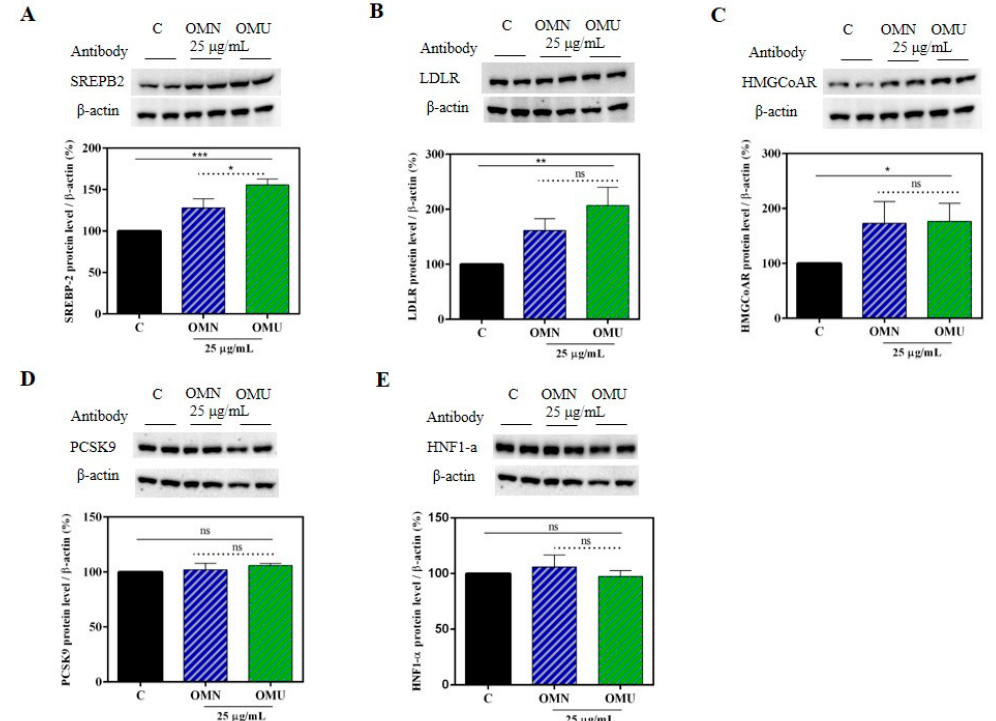
Figure 6. Modulation of cholesterol biosynthesis. ( A ) Western blot of SREBP-2 (precursor); ( B ) western blot of the LDLR; ( C ) western blot of HMGCoAR; ( D ) western blot of PCSK9; ( E ) western blot of HNF1- α . Data represent the mean ± s.d. of eight independent experiments performed in duplicate. All the data sets were analyzed by One-way ANOVA and OMN vs OMU by t-student test. (*) p < 0.5; (**) p < 0.01; (***) p < 0.001; ns: not significant. C: control sample.